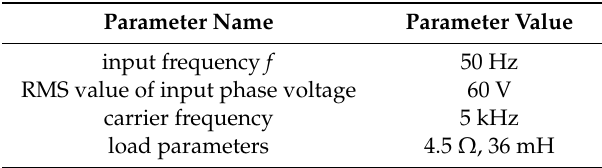
Table 3. Experimental